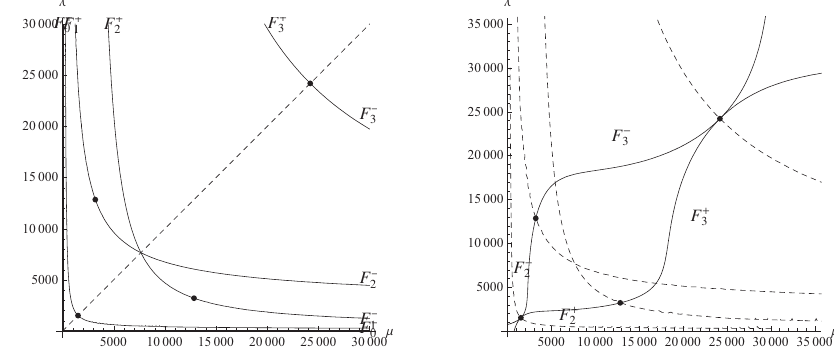
Figure 2. The spectrum for the problems (1.5), (2.1) and (1.5),